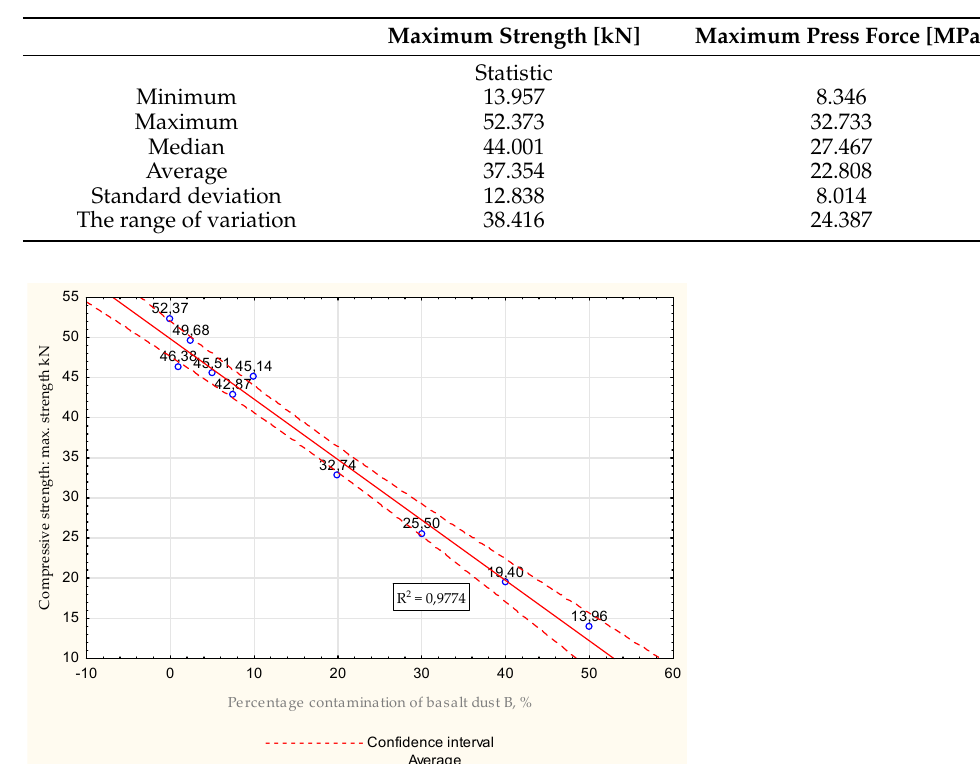
28 days. Table 20. Compressive strength tests for basalt dust B for all samples for water − mix ratio = 0.6 after